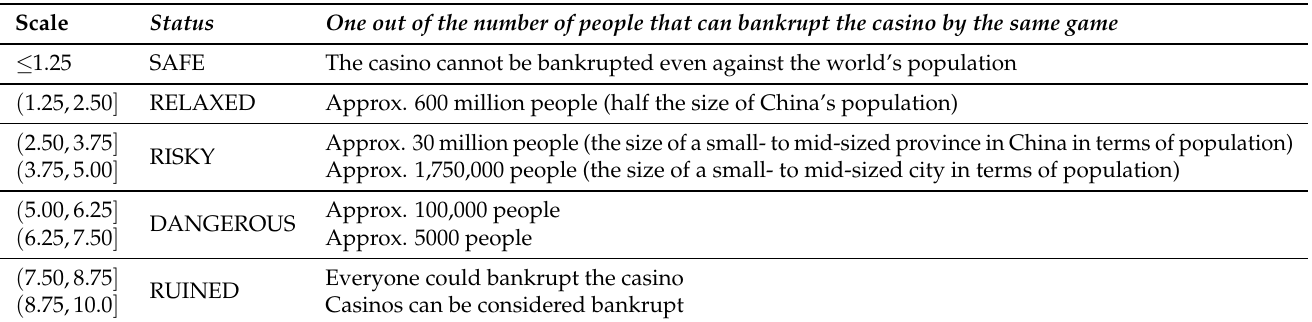
Table 6. A description of ROR ( x ) according to the world’s